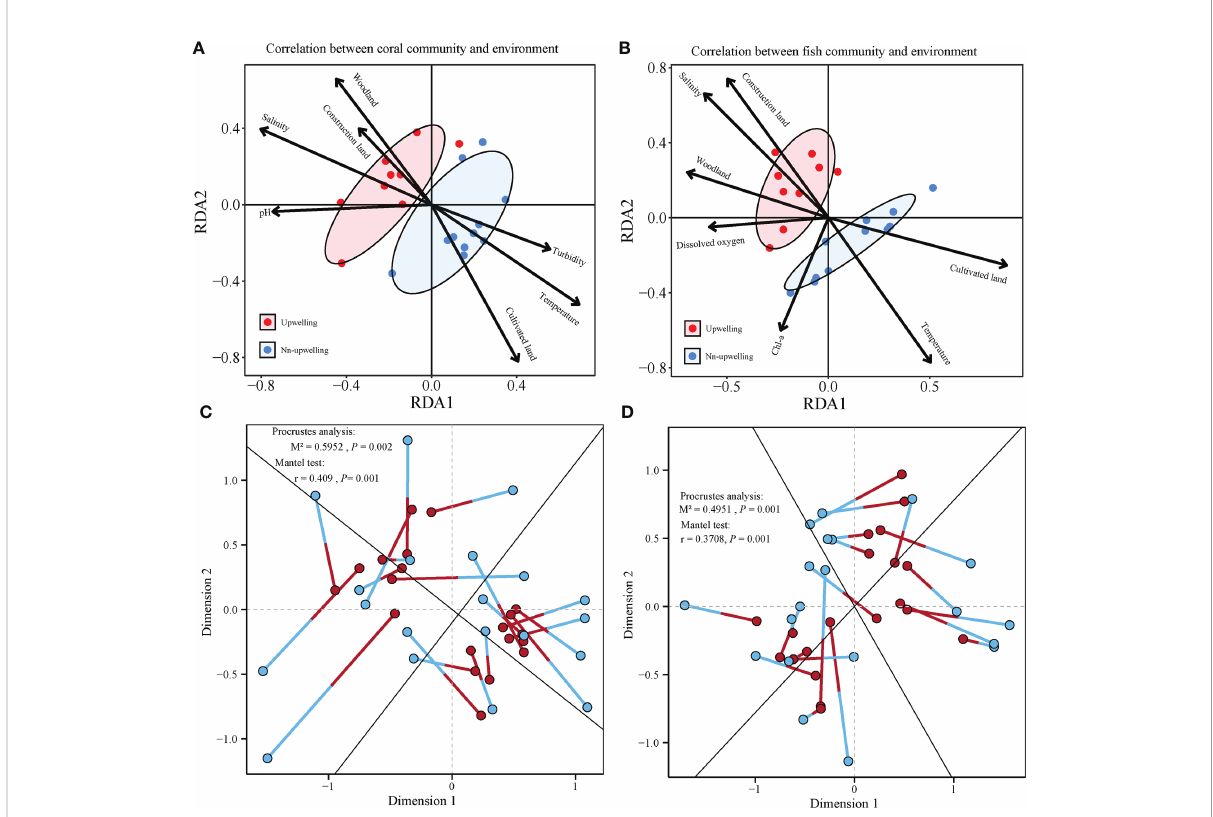
FIGURE 6 Correlation between environmental factors and coral community. Redundancy analysis (RDA) of (A) hard coral and (B) fi sh abundance at species level and environmental characteristics. The Procrustes analysis of (C) coral compositions and (D) fi sh community depicts signi fi cant correlations with environmental